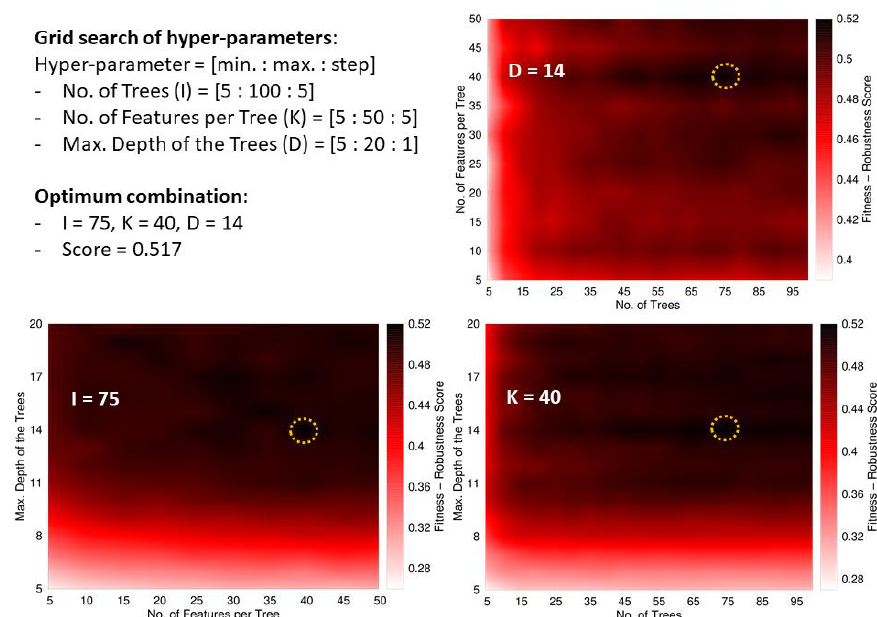
Figure 2. Tuning scheme of the RF’s hyperparameters. The top-left panel summarizes the boundaries and binning of the grid search with the three hyper-parameters. This panel also shows the optimum value found for the FRS function and the values of the hyper-parameters in the corresponding solution. The remaining panels show surfaces plotted as heat maps keeping one of the hyper- parameters fixed at its optimum value. The dark regions indicate the best solutions. The optimum regions are highlighted with a dashed circle. The plots highlight that the most critical parameter is the depth of the trees, while high-scored models can be obtained with almost any value of the other hyper-parameters; solutions with a depth below 10 are poorly scored.